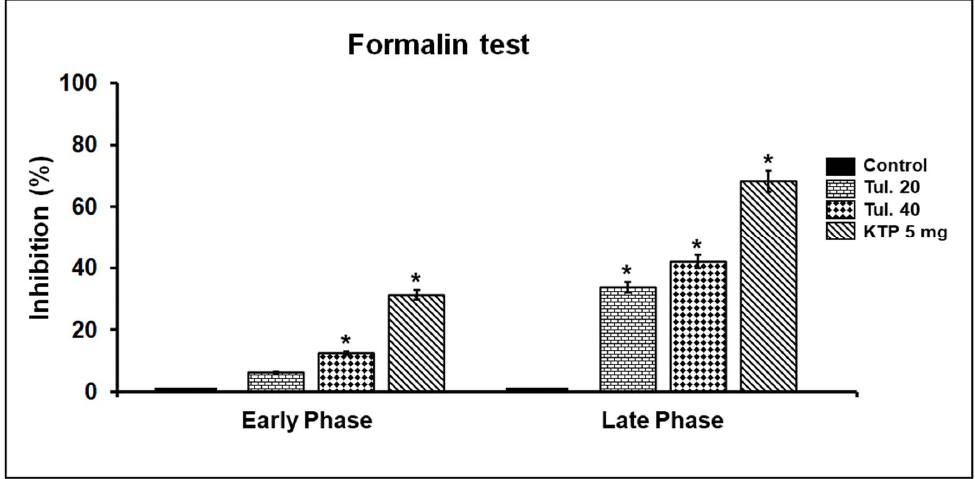
Figure 5. The percentage of inhibition induced by tulathromycin (20 (Tul. 20) and 40 (Tul. 40) mg/kg BW s.c.) and keto- profen (KTP; 5 mg/kg BW s.c.) against the nociceptive responses triggered by s.c. injection of formalin (20 uL of 2.5%, v / v ) in the dorsum of the hind right paw in mice. Data are expressed in mean ± SD; n = 5. * Significantly different from control, p < 0.05.